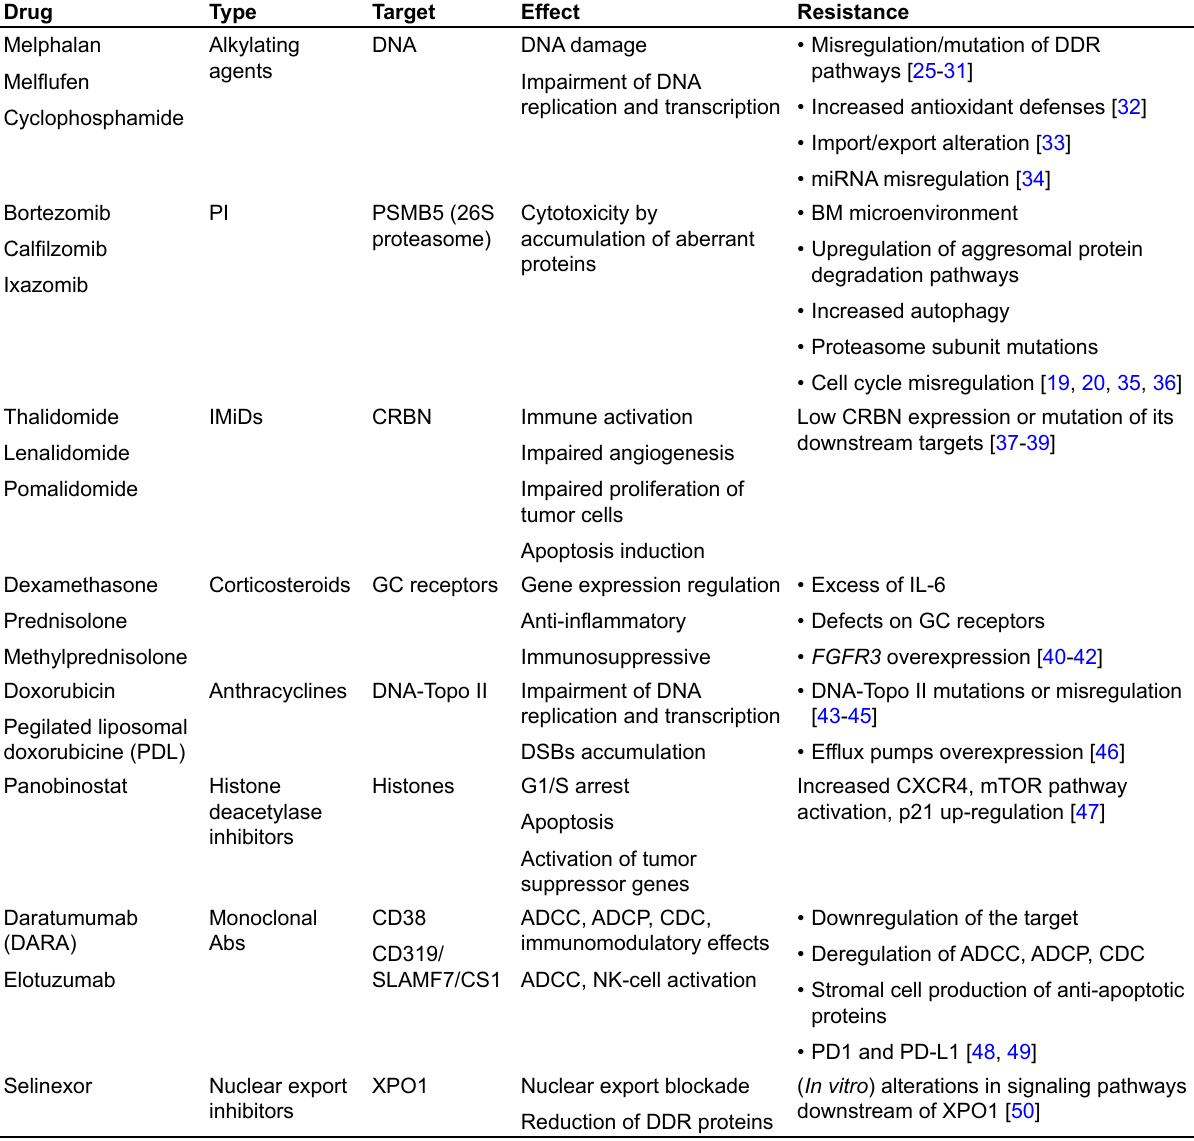
Table 1. Agents approved for MM treatment